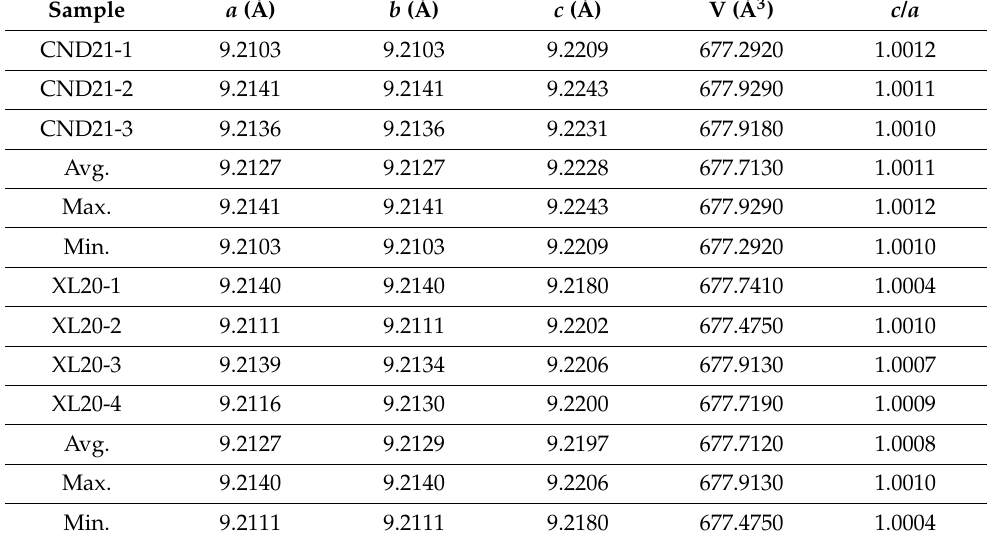
Table 3. In situ micro-X-ray diffraction (XRD) analysis results of beryls from the Xianglin